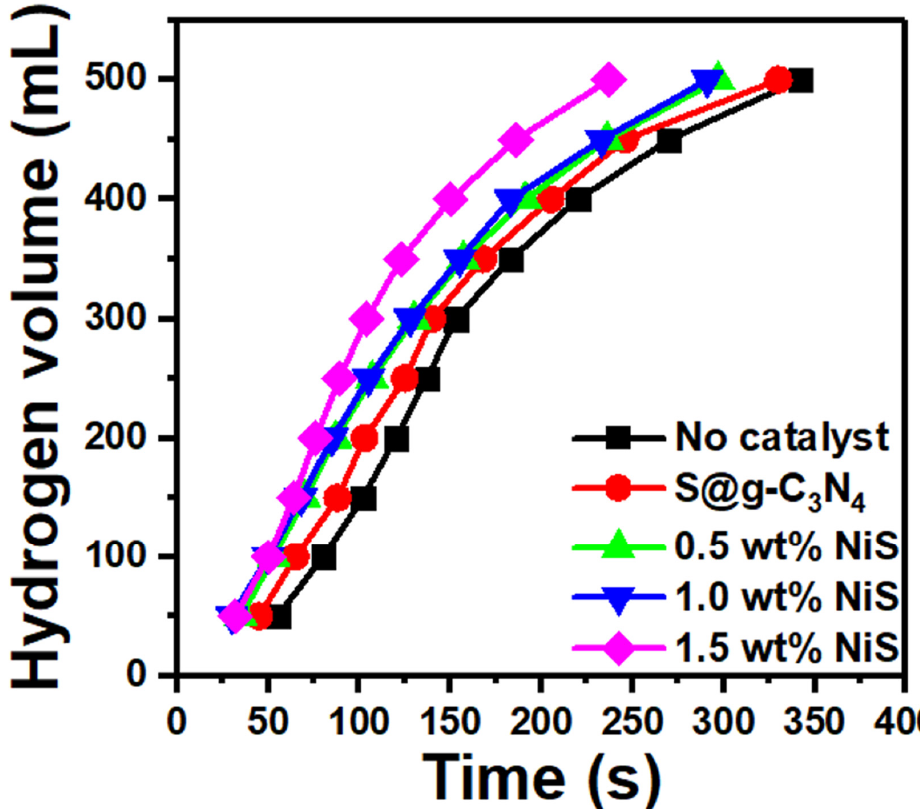
Figure 8. Hydrogen production from methanolysis of NaBH 4 of S@g-C 3 N 4 and NiS-g-C 3 N 4 nanocomposites.